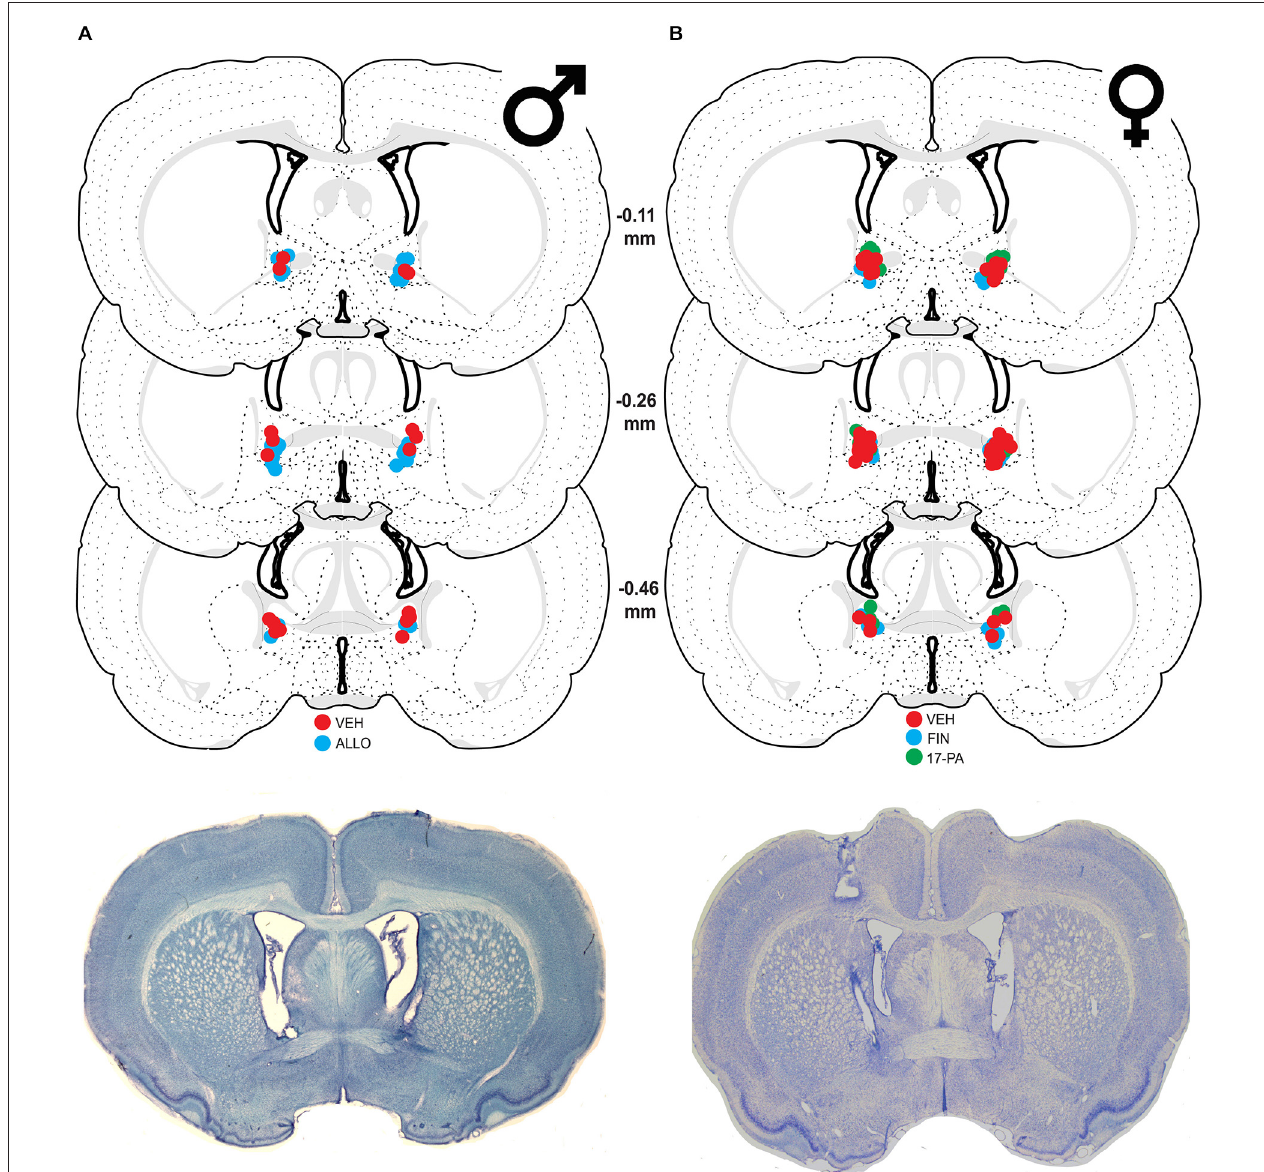
(red circles) and ALLO (blue circles) in male rats with photomicrograph of a representative section. (B) Infusion sites for VEH (red circles), FIN (blue circles), and 17-PA (green circles) in female rats with photomicrograph of a representative section. Coronal brain section images adapted from Swanson